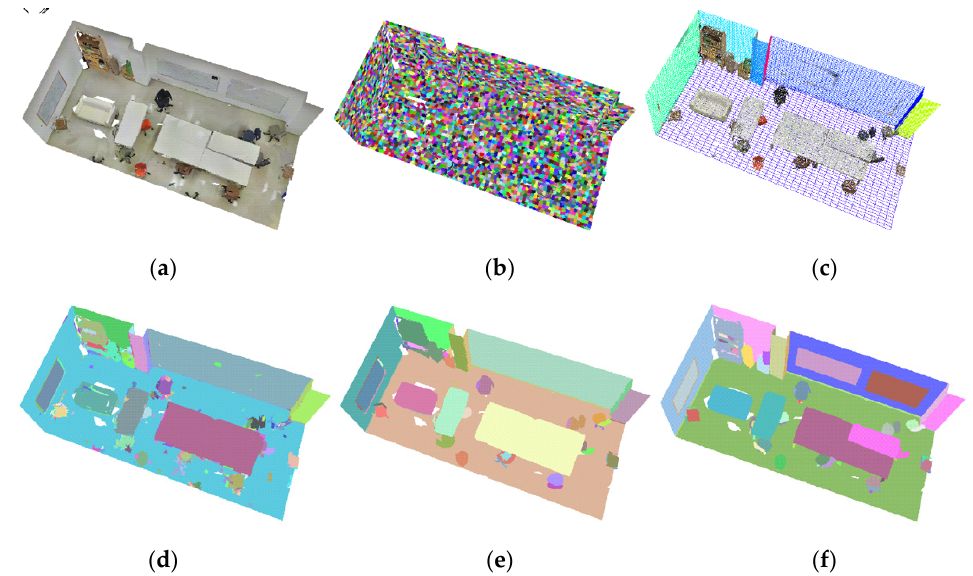
Figure 4. The segmentation result of the conference room. ( a ) Raw point clouds ( b ) The generated surface patches. ( c ) The extracted indoor structural planes set and leftover points of the scene. ( d ) The indoor segmentations after multi-constraint graph clustering. ( e ) The final segmentation result after post-refinement. ( f ) The ground truth.